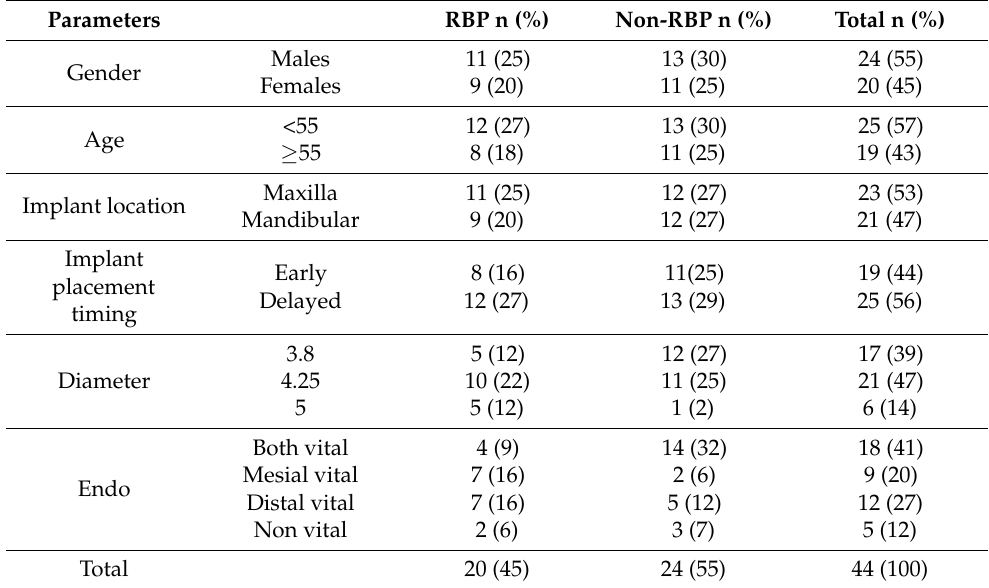
Table 1. Distribution and number of the analyzed implants according to the evaluated parameters. Parameters